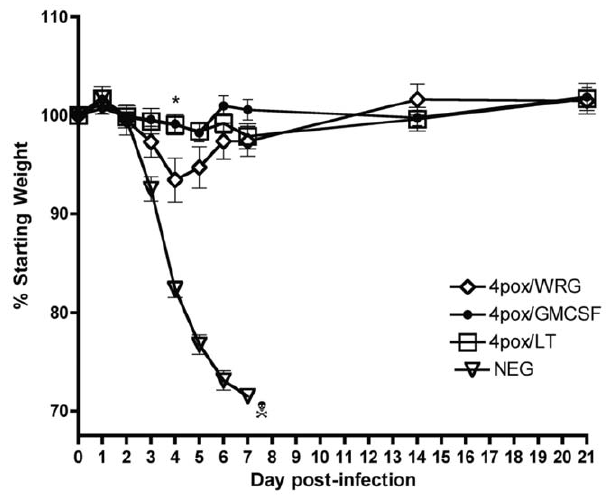
Figure 2. VACV challenge of vaccinated mice. Groups of seven to eight mice vaccinated twice by gene-gun with the indicated DNA vaccine were challenged with 2 6 10 6 pfu of VACV strain IHD-J by the i.n. route. Weights of individual mice were monitored for 21 DPI. The percent weights of surviving mice were calculated relative to starting weights (day 0). Mean % weight loss 6 standard error of the mean (SEM) were plotted. On day 4 postinfection, there was a significant difference in weight loss between 4pox/WRG versus 4pox/GMCSF (p=0.0336) or 4pox/LT (p=0.0384), this point is denoted by an asterisk. Poison symbol indicates all animals in the group became moribund and were euthanized.